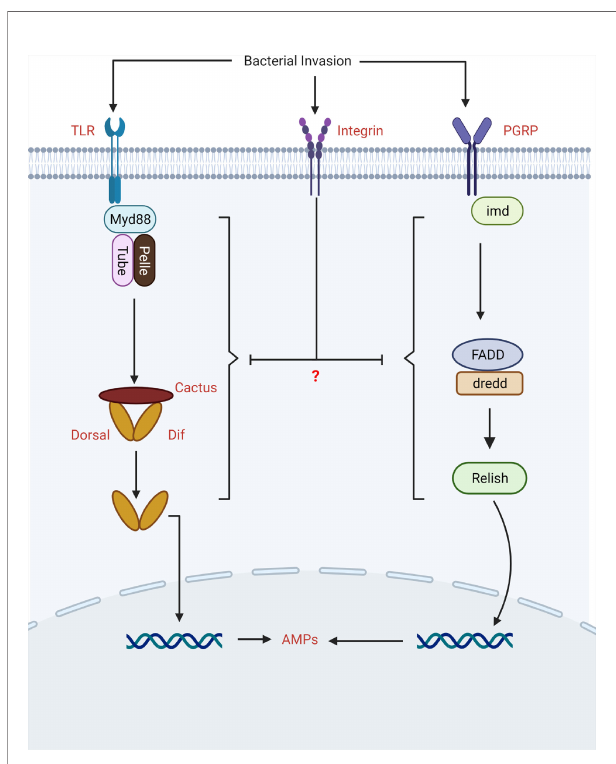
FIGURE 3 | The biological role of integrins in the modulation of Toll and IMD